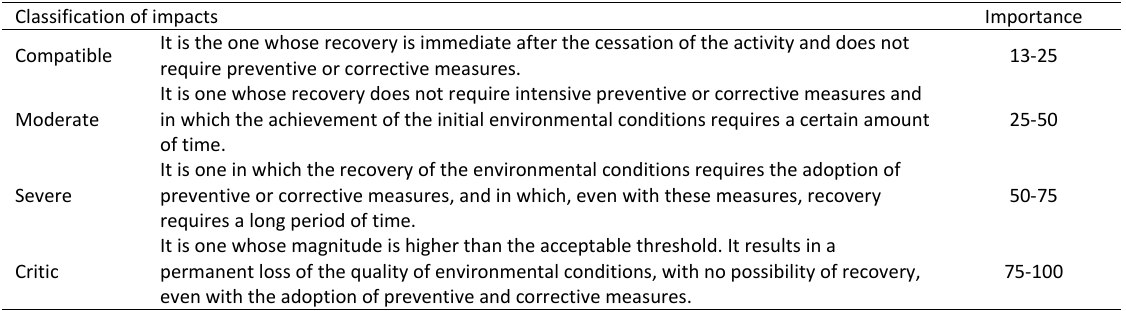
Table 1: Classification of impacts and its importance